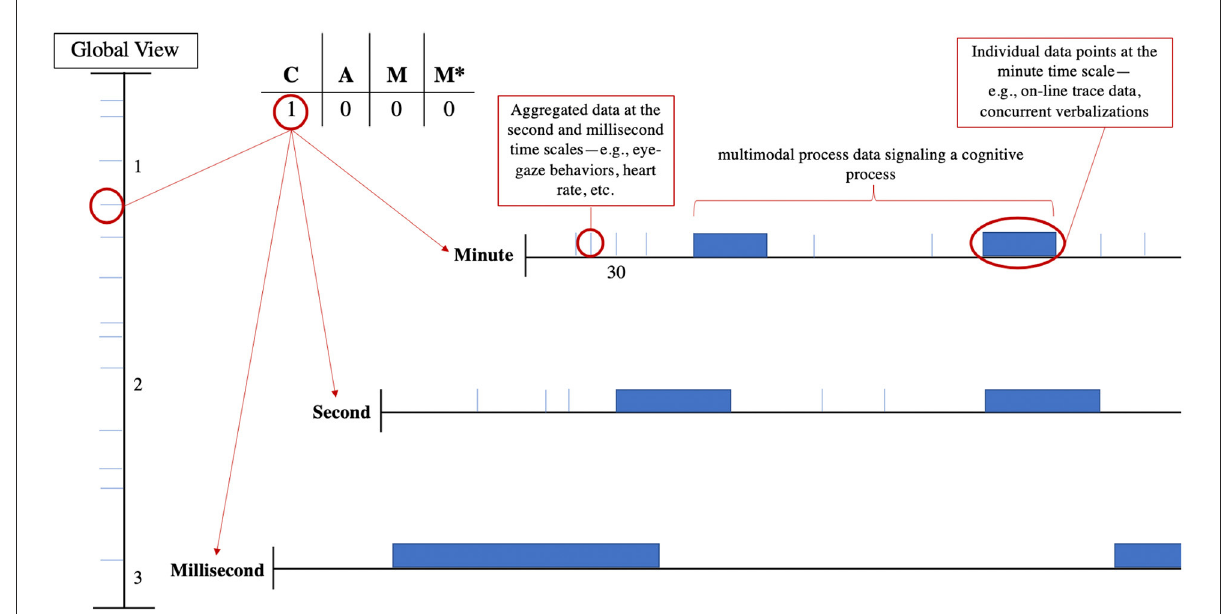
FIGURE5 Scaling from a global view of SRL constructs at the hour temporal scale to the minute, second, and millisecond temporal scale of signals. C, cognitive; A, affective; M, meta-cognitive; M*,